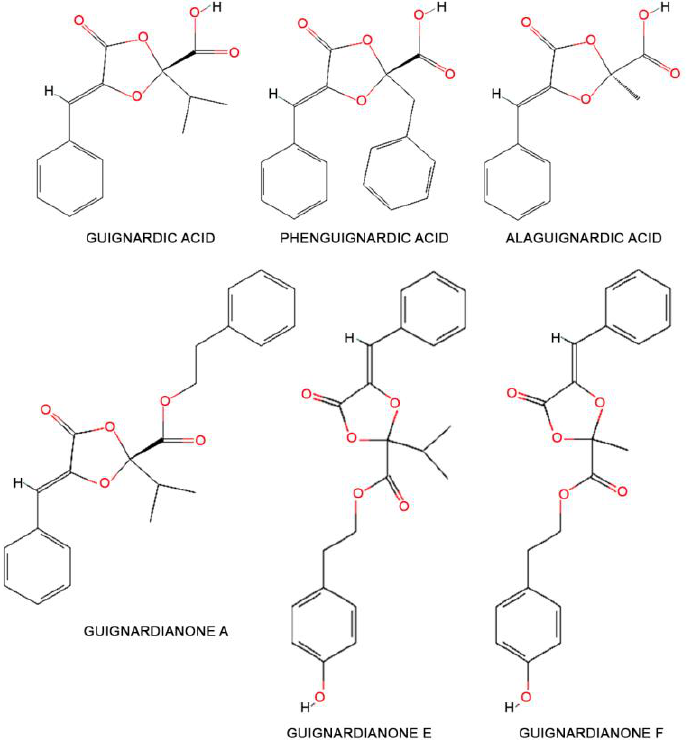
Figure 4. 2D structures of phytotoxic secondary metabolites of grape black rot discovered to date [139 – 144].